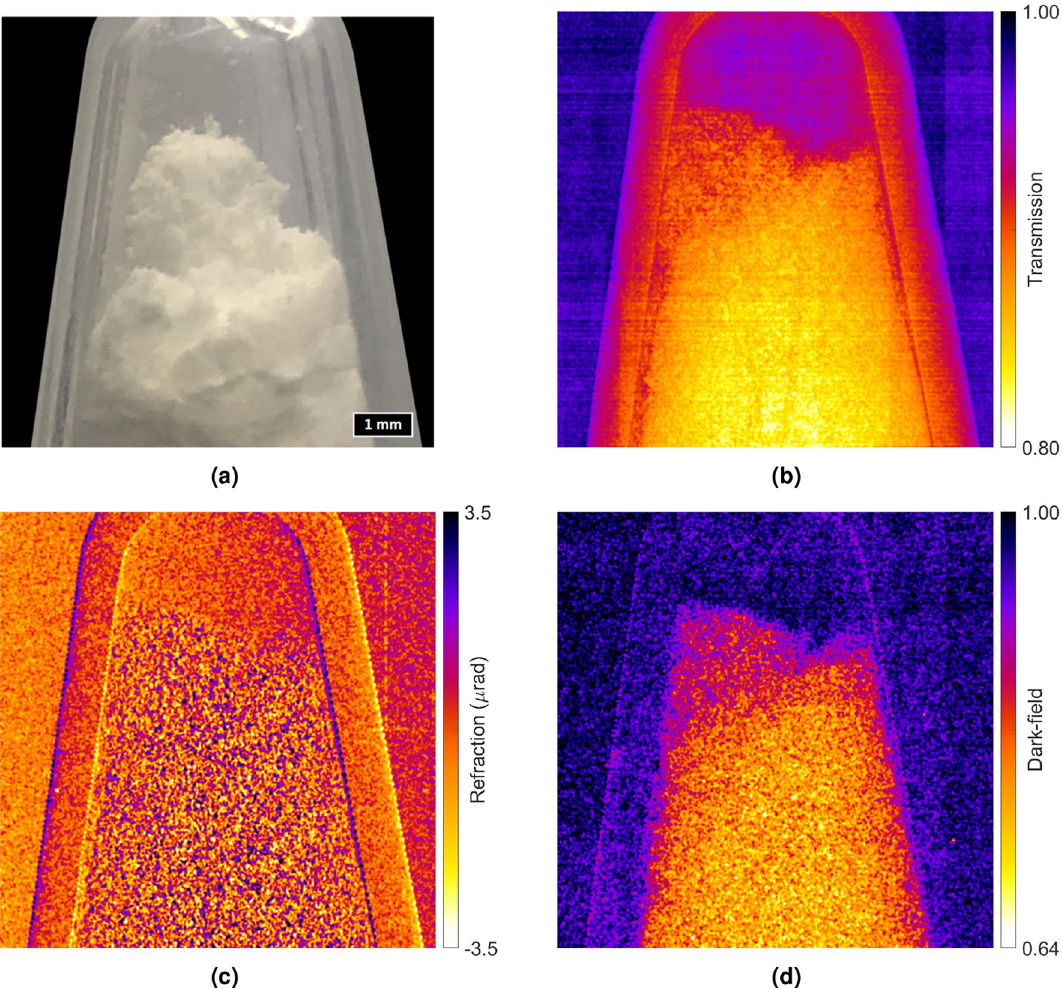
Figure 11. ( a ) A centrifuge tube filled with sugar powder as the sample of interest. ( b ) Transmission, ( c ) refraction, and ( d ) dark-field images retrieved from a single-exposure X-ray phase-contrast image taken at 60 kV p of the sample—images are represented based on a false color tone for better representation. As evident in the three contrast images, the grating artifacts do not show up in the final processed